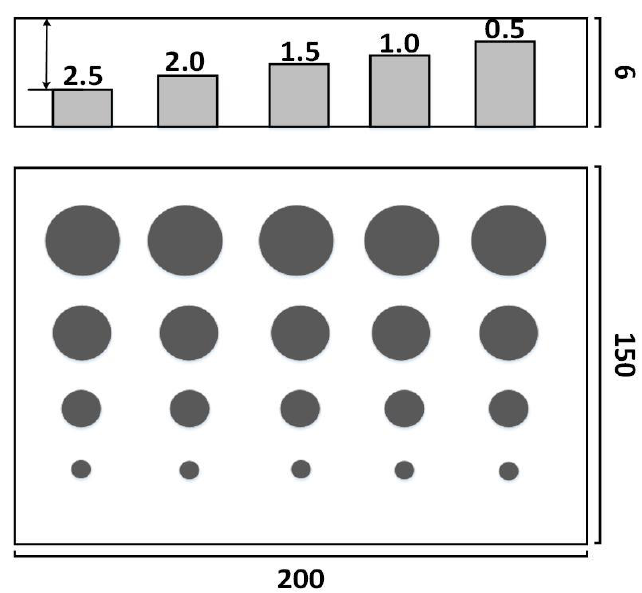
Figure 2. Schematics of defect distribution in the glass-fiber-reinforced plastic (GFRP) panels.